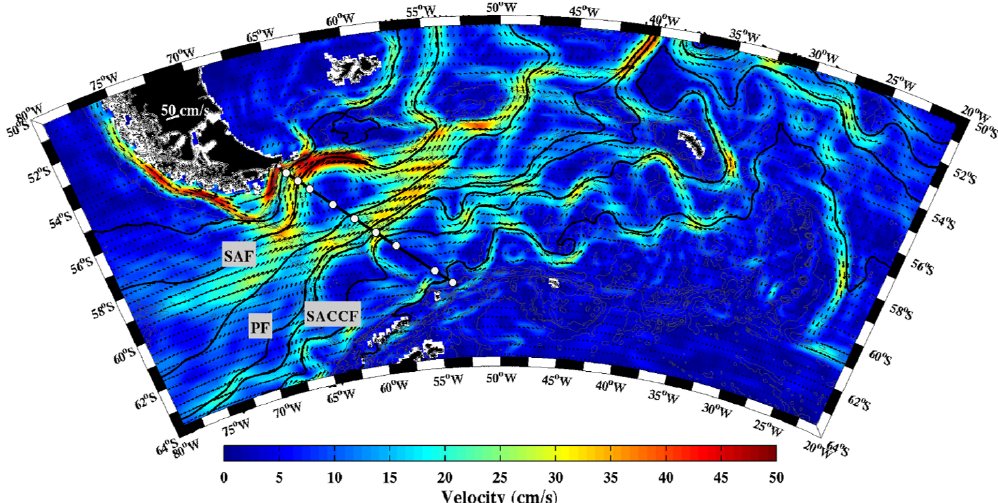
Figure 18. Mean surface velocity magnitude (in cms − 1 ) and mean surface velocity vectors from MDT CNES-CLS18. Black lines are isolines of mean sea surface height corresponding to the main Antarctic Circumpolar Current (ACC) fronts and their branches: SAF-N (23cm), SAF- M (0cm), PF-N (43cm), PF-M ( − 70cm), PF-S ( − 79cm), SACCF-N ( − 93cm) and SACCF-S ( − 114cm). White dots indicate the position of the DRAKE